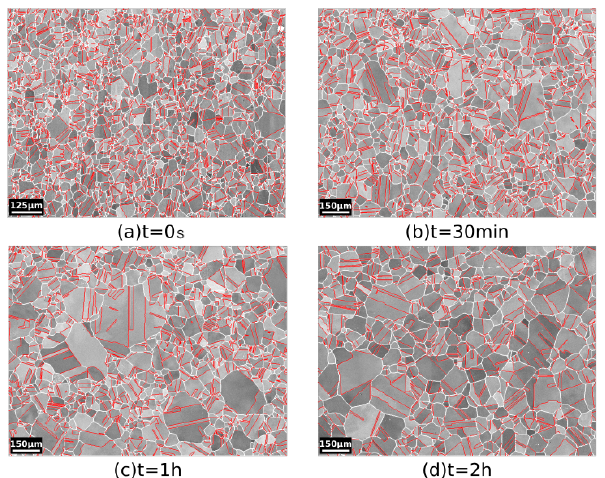
Figure 3. Annealing at 1050 ◦ C: band contrast map of the microstructure of 316L steel at ( a ) t = 0 s, ( b ) t = 30 min, ( c ) t = 1 h, and ( d ) t = 2 h. Grain boundaries are depicted in white and Σ 3 TBs are predicted in